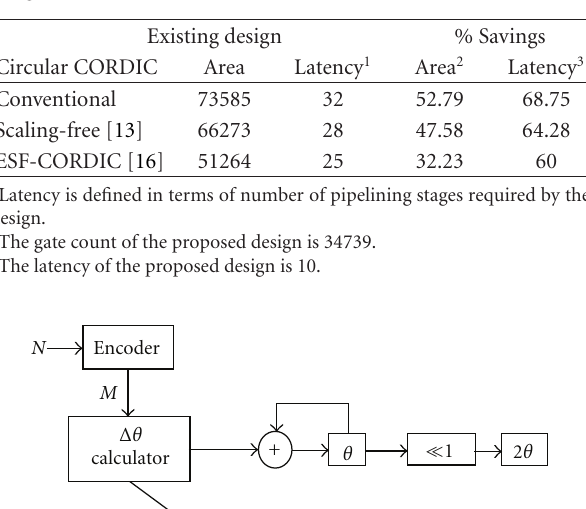
Table 3: Complexity comparison of proposed design with existing design variants.